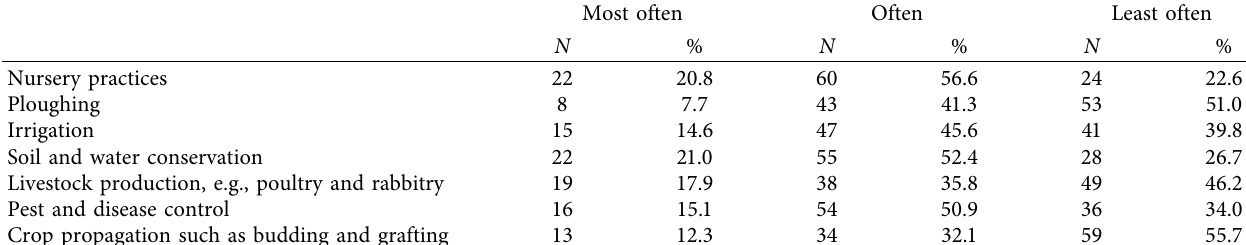
Table 3: Agriculture teachers’ opinions on the frequency of the use of the skills developed for food security.